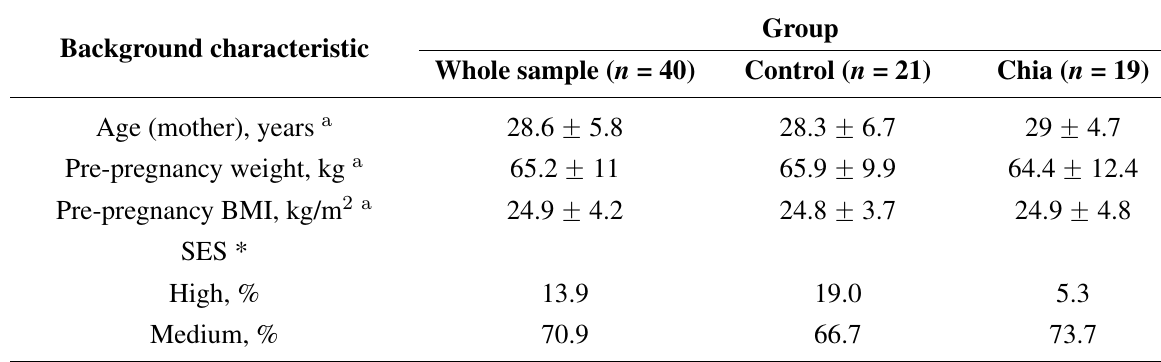
Table 1. Background characteristics of both experimental